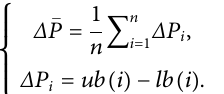
model, four datasets are selected for testing, one of which is shown in Figure 3 . Each dataset uses a data length of 7 days consisting of 672 wind speed time series. Take approximately 80% of the data from every set as a training set and take the remaining portion as a validation set. The training set is used to calibrate the parameters of the beta – ARQEA – SWLSTM model and the validation set is used to